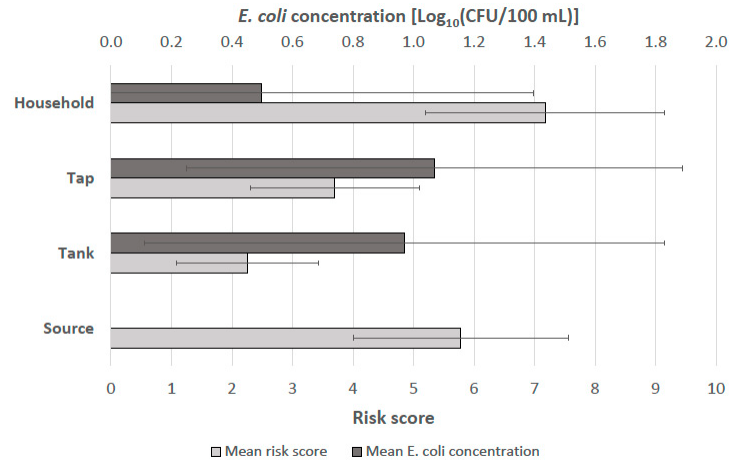
Figure 4. Mean risk scores from monthly sanitary inspections and mean Escherichia coli concentrations from monthly sampling ( n = 23, standard deviation bars shown). The maximum risk score is